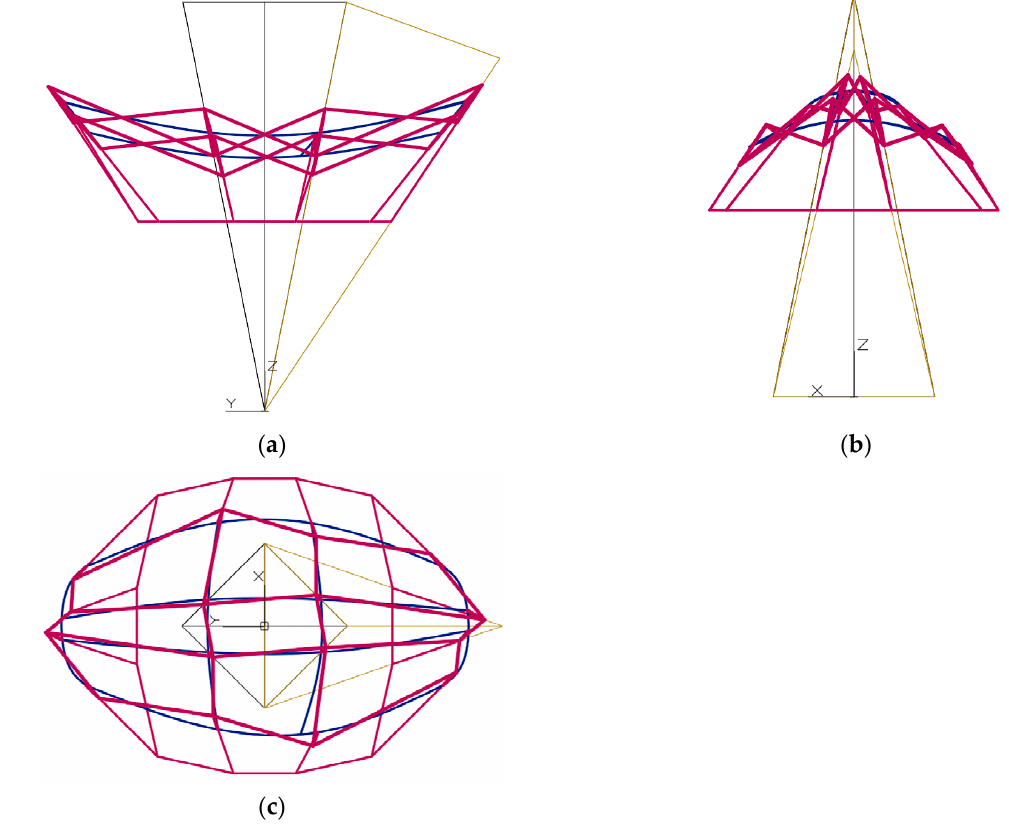
Figure 11. The designed reference network Γ , the second eaves network B v , and the second complex building structure Σ : ( a ) the front view, ( b ) the back view, ( c ) the top view.